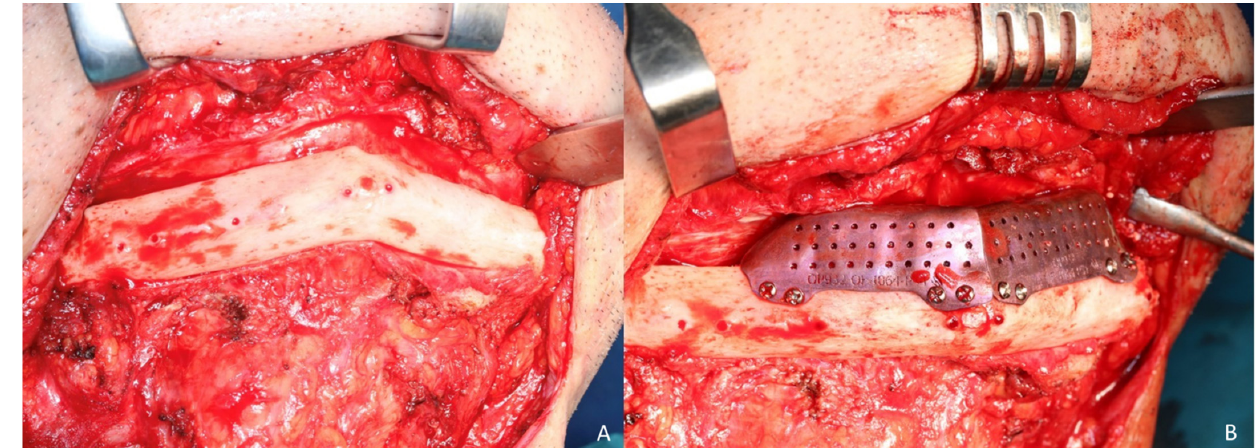
Figure 5. 3D reconstruction of fibula flap. ( A ) Cervical approach to avoid intraoral communication and exposure of the peroneal flap with good bone vascularization. ( B ) Iliac crest cortico-cancellous graft to reconstruct mandibular height and preserve the horizontal dimension of the fibula. Adjustment of the titanium mesh to the upper and lateral part of the two fibula segments with 1.5 mm screws.